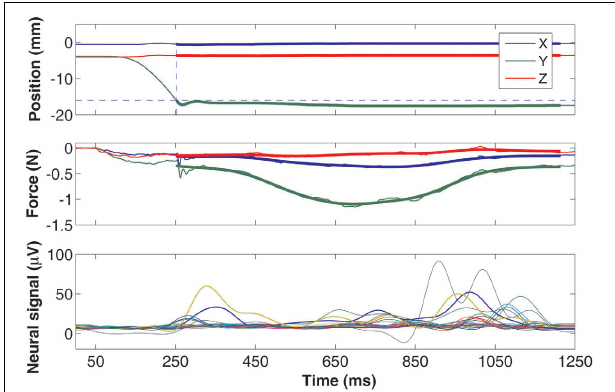
FIGURE 5 | Plots of position (top) and force traces (middle) from a typical lever press trial ( Y in green is vertical, X in blue and Z in red are horizontal components). The position of the lever is moved from its initial position and reaches the target level (dashed horizontal line) at the dashed vertical line. A threshold force value of 0.11N was used to determine the starting and ending points of the isometric region. The forces from the isometric portion of the trial used in regression analysis are filtered by an 8Hz low-pass and plotted as thick lines. The bottom plot shows the rectified-filtered version of all the neural channels.